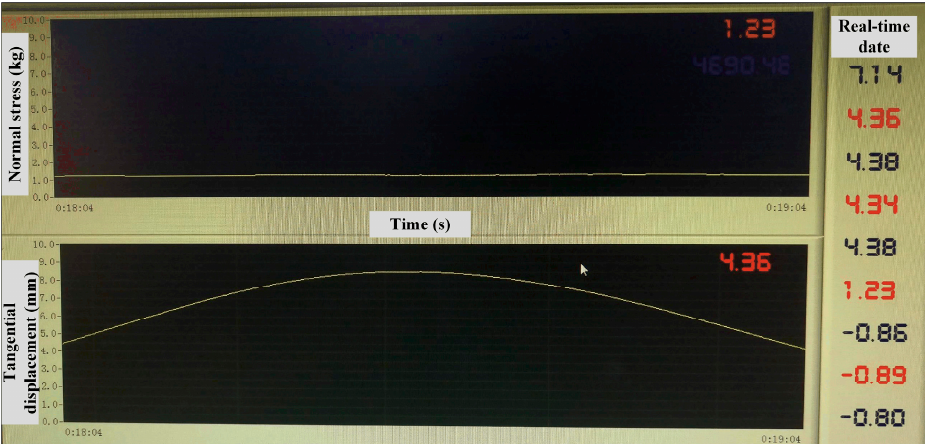
Figure 4. Data acquisition system.